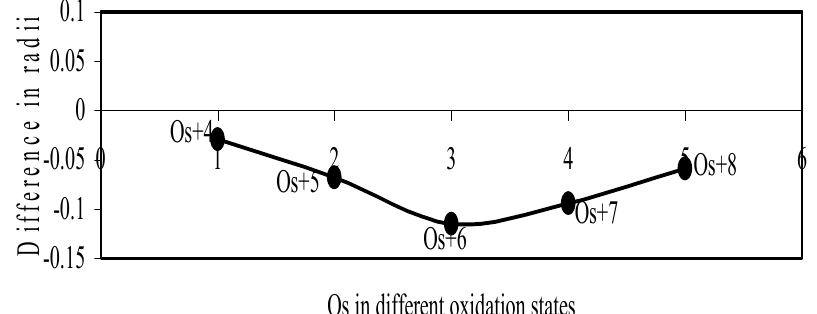
Figure 22. Plot of difference in experimental and theoretical radii of Os in different oxidation states.